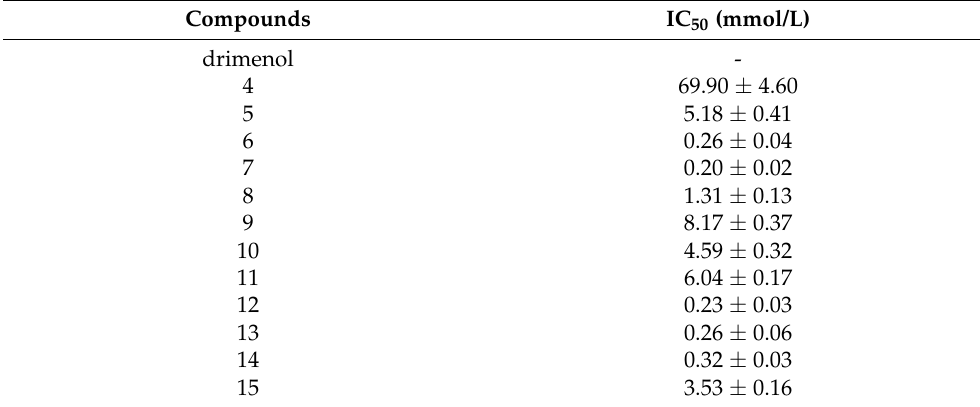
Table 1. Fungitoxicity on B. cinerea of the synthesized